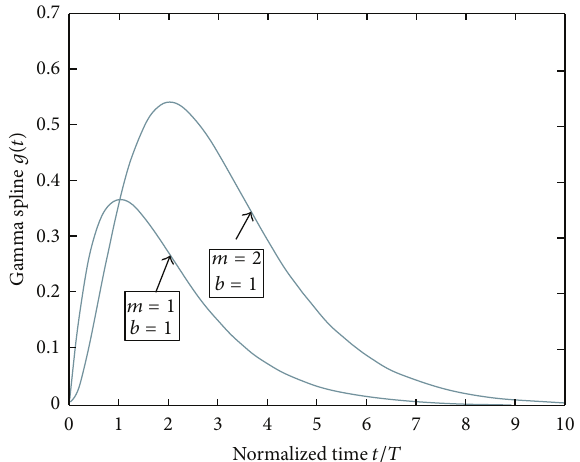
Figure 1: Two typical gamma spline